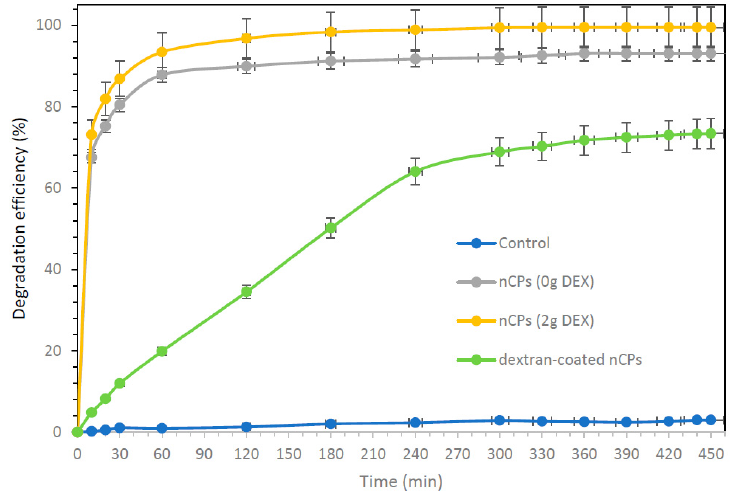
Figure 12. The degradation of DOX using nCPs (0g DEX), nCPs (2g DEX) and dextran-coated nCPs (2g DEX) catalyzed by Fe(II), concentration of DOX = 60 mg/L, concentration of Fe(II) = 1 mM, nCPs = 600 mg/L.